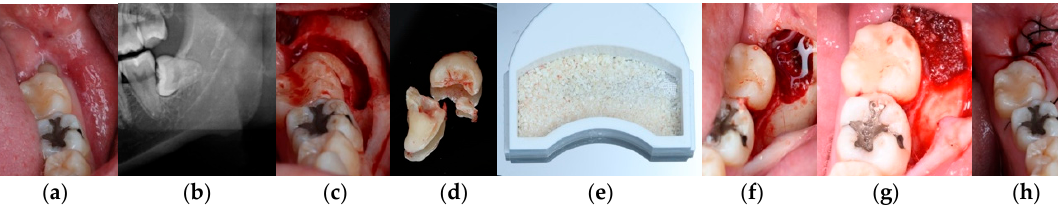
Figure 2. Treatment sequence on test side. ( a ) Baseline. ( b ) Panoramic radiograph. ( c ) Osteotomy. ( d ) Tooth fragments. ( e ) Graft material. ( f ) Graft material in the alveolus. ( g ) Fibrin sponge over the graft. ( h ) Suture.